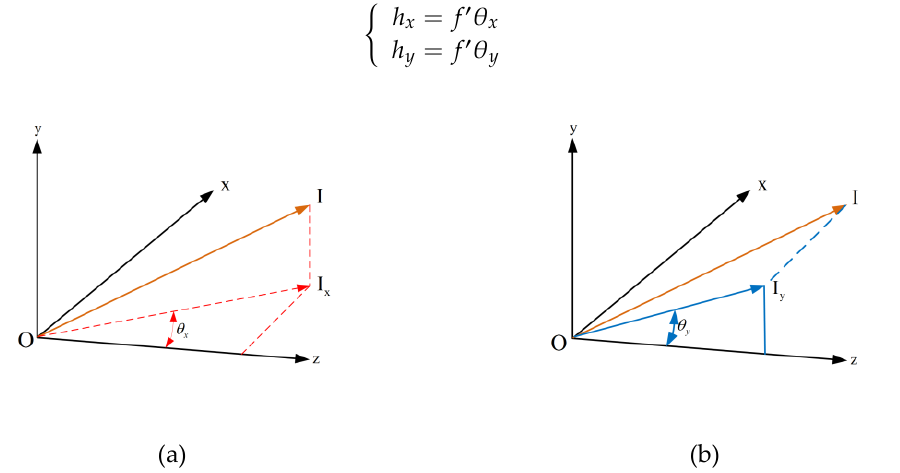
Figure 2. The field of views (FOVs) in object space are conventionally defined for optics, based on the x-y-z coordinate system. The optical axis is Oz. OI is the chief ray of a certain FOV. ( a ) The projection of OI on the xOz plane is OI x . The angle between OI x and Oz is θ x , which is defined as the FOV in x direction of the chief ray OI. ( b ) The projection of OI on the yOz plane is OI y . The angle between OI y and Oz is θ y , which is defined as the FOV in y direction of the chief ray OI .